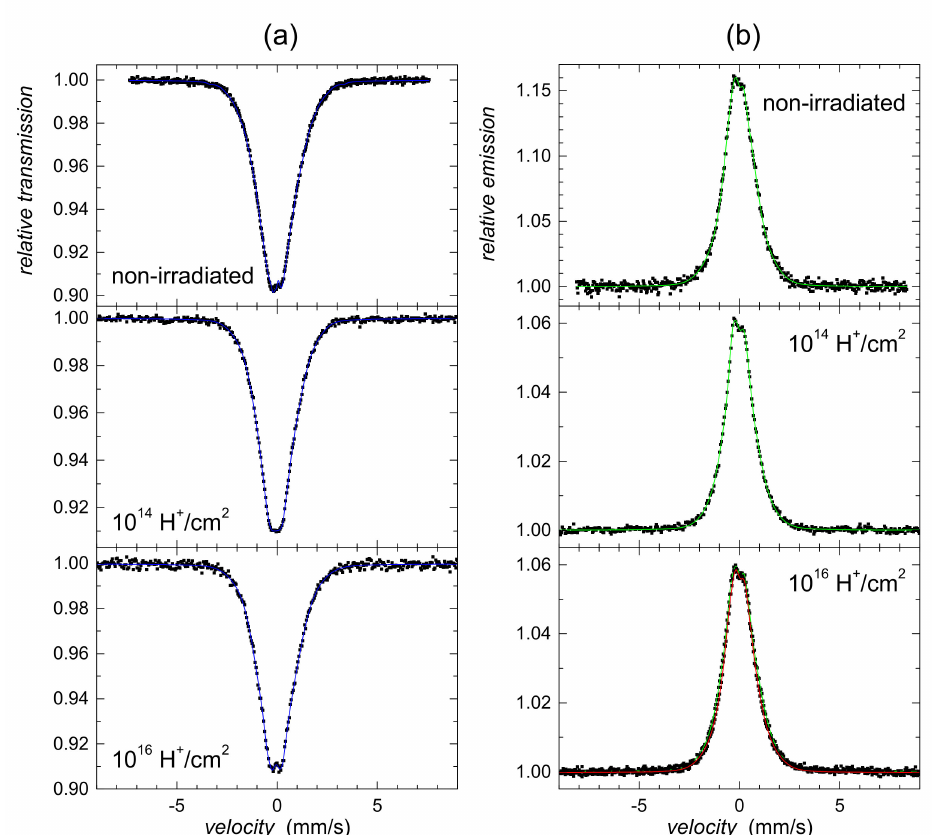
Figure 1. Mössbauer spectra of Fe 76 Mo 8 Cu 1 B 15 amorphous metallic alloy irradiated by 80 keV H + ions with the indicated fluences: ( a ) Transmission geometry (blue); ( b ) conversion electron Mössbauer spectroscopy (CEMS, green). Mössbauer spectrum taken from the wheel side of the ribbons is shown for comparison in ( b )